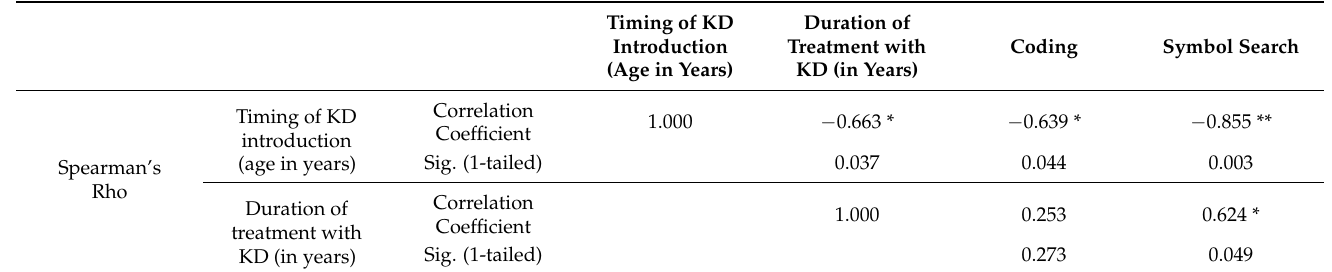
Table 4. Correlation between subtests of processing speed index (PSI) and timing of KDT introduc- tion/duration of treatment with KDT.